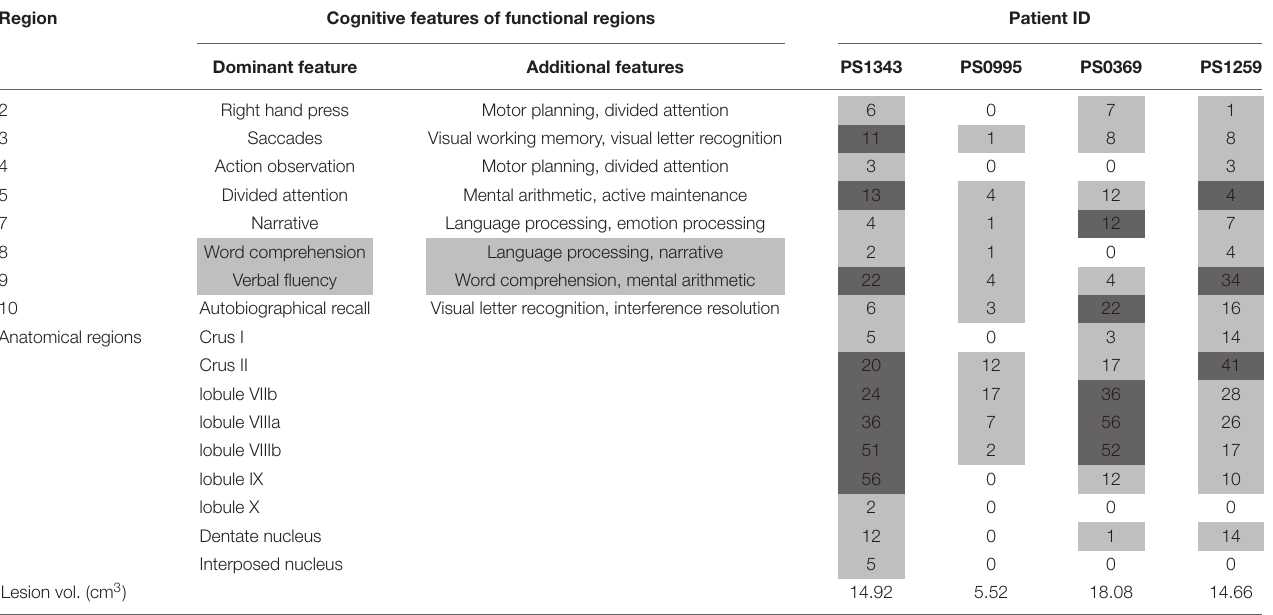
TABLE 3 | Percent overlap between functional and anatomical regions, and patients’ lesions.